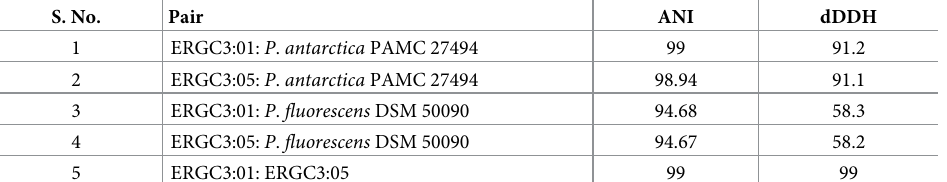
Table 2. Average nucleotide identity (ANI) and digital DNA: DNA hybridisation (dDDH) values between geno- mic pairs. S.